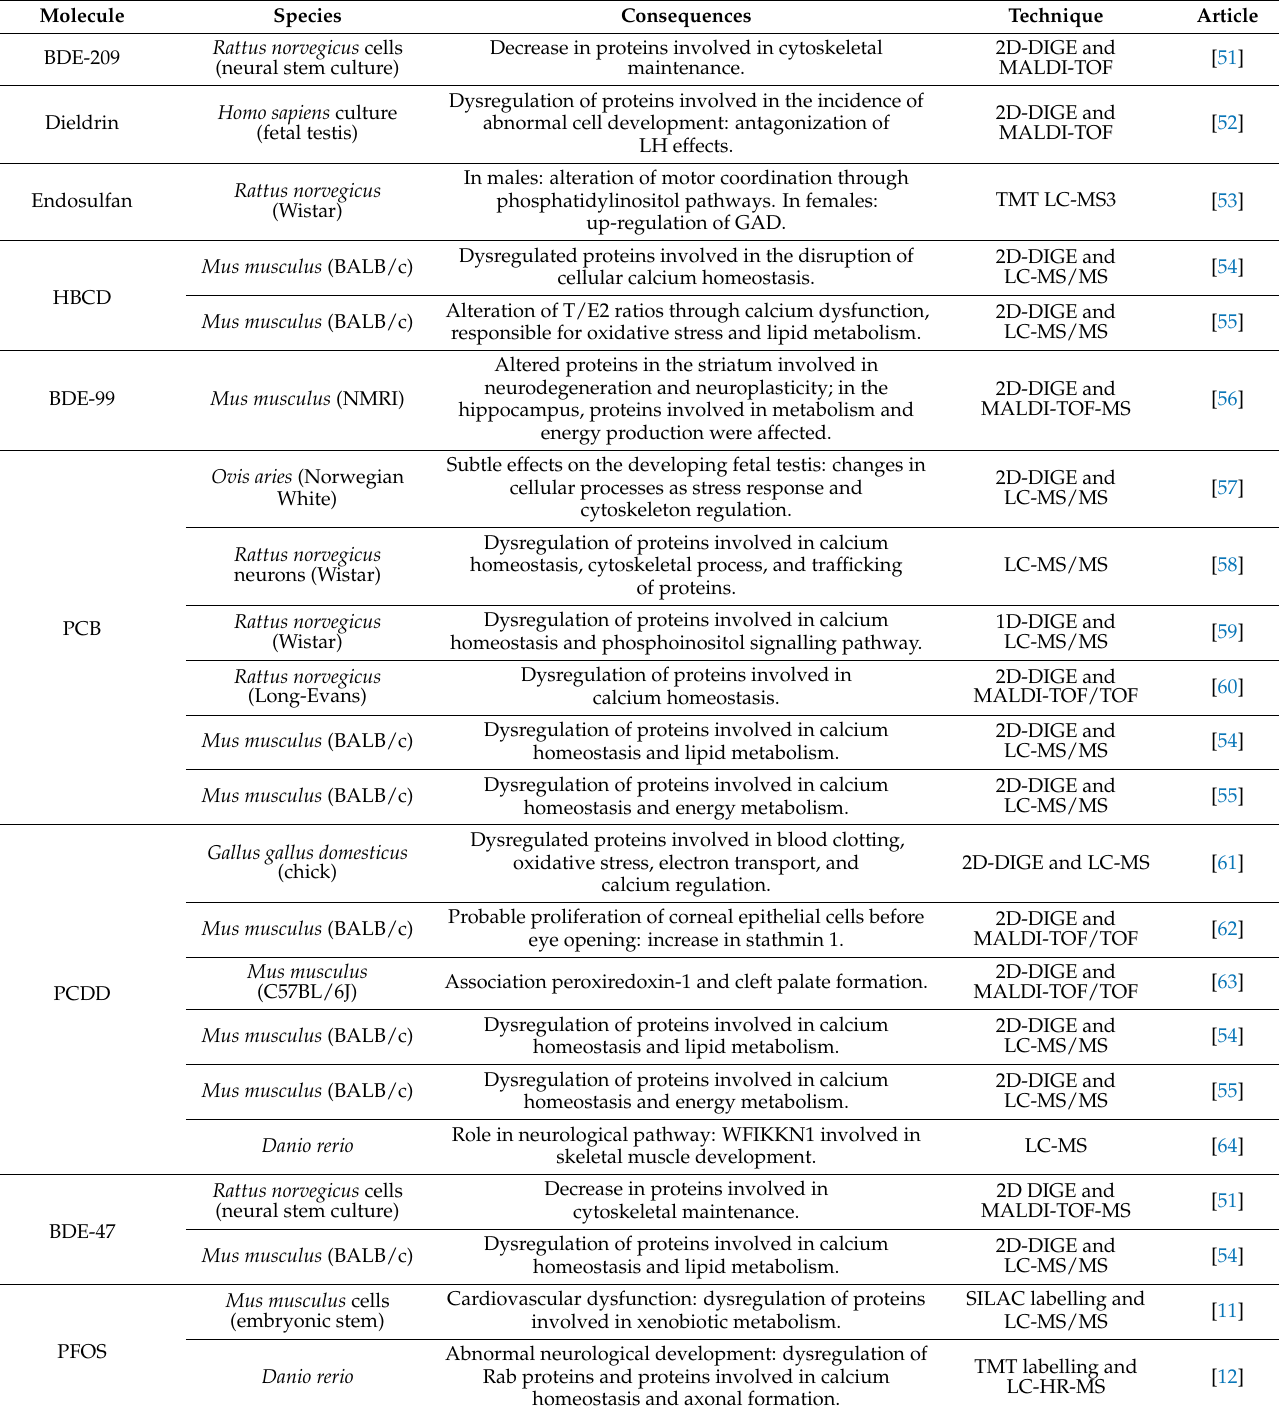
Table 2. Articles describing POP-induced developmental